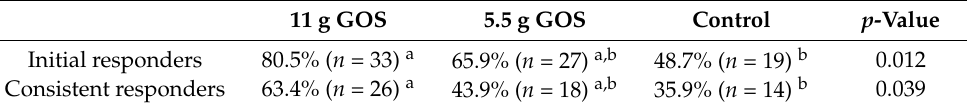
Table 4. Initial responders (subjects with an increase in stool frequency in week 1) and consistent responders (subjects with an increase in stool frequency at week 1 still present at week 3) from the PP population in all three intervention groups (percentages and counts). The p -value represents the outcome of the Chi-square test in which the three intervention groups were compared.